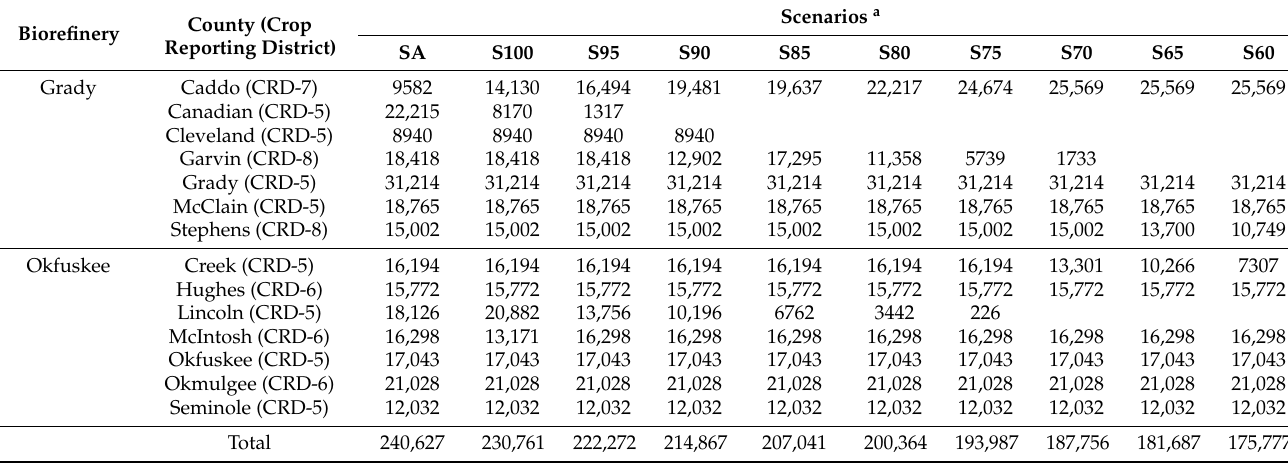
Table 4. Switchgrass area (ha) and location under different